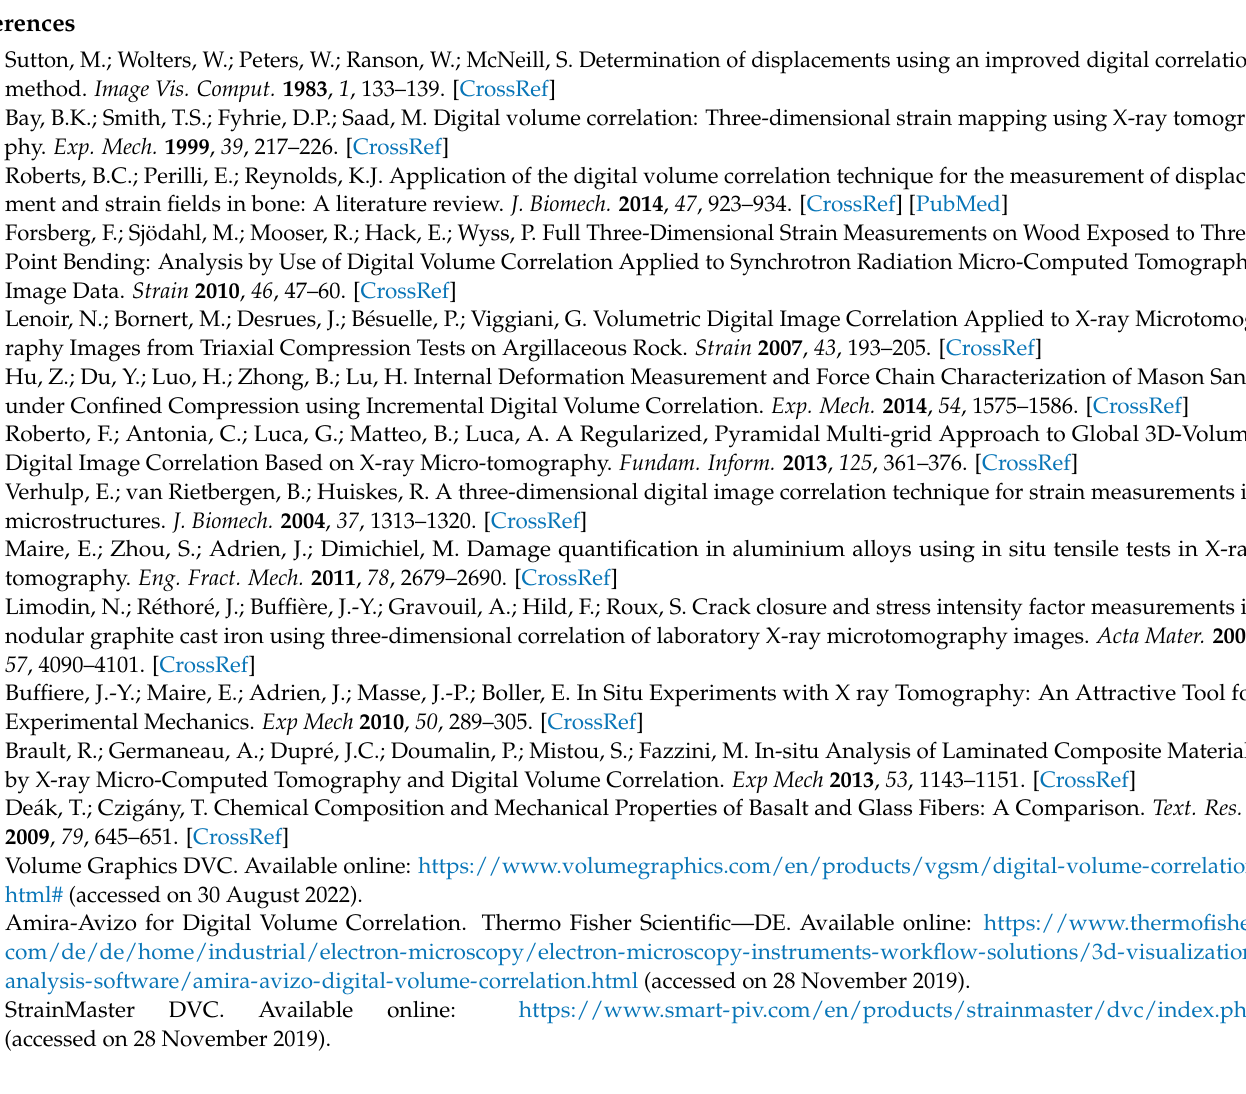
Figure A5. Exemplary evolution of the similarity metric and its gradient in the final resolution of a DVC run as a function of the number of iterations used. It is reasonable to expect that an increase in the number of iterations would be ac- companied by an improvement in the recovered displacement field. However, Figure A5 shows that a plateau region is reached after 150 iterations. Further iterations do not appear to improve the result. It also shows that the correlation metric value as output by Elastix corresponds very well with our definition of the exact error (c.f, Equation (A1)). This indicates that the correlation metric value can be used to monitor convergence.